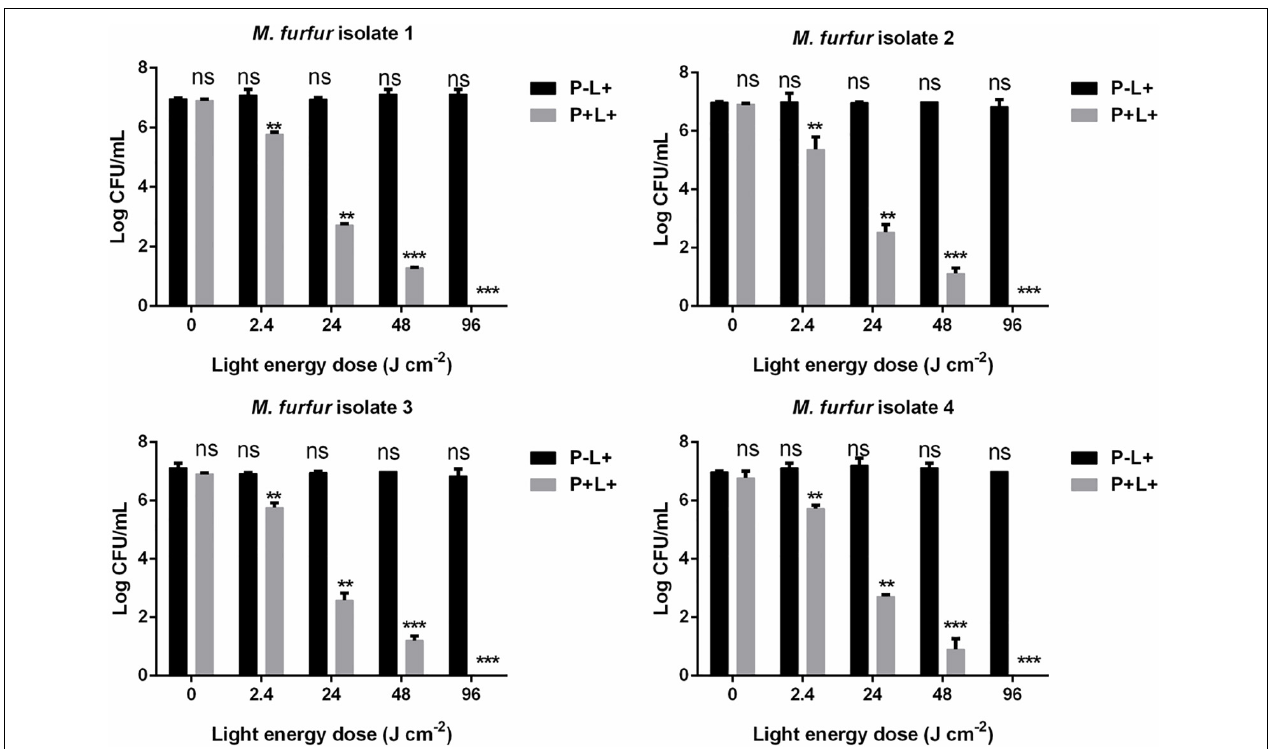
FIGURE 5 | Survival of M. furfur clinical isolates after aPDT mediated by AE. (P–L + ) represents the M. furfur cells irradiated with different energy doses of light; (P + L + ) represents the M. furfur cells treated with 10 µ M of AE and irradiated with different energy doses of light. Each value refers to mean ± standard deviation (SD; n = 3; ns: no significance, ** P < 0.01, *** P <